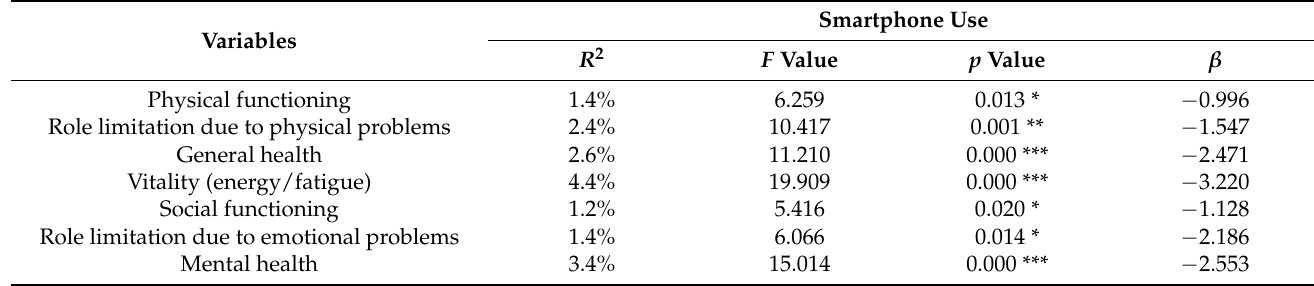
Table 3. Summary of the stepwise multiple linear regressions of the durations of smartphone use as predictors of the physical and mental domains of SF-36 in early female adolescents during COVID-19 ( n =